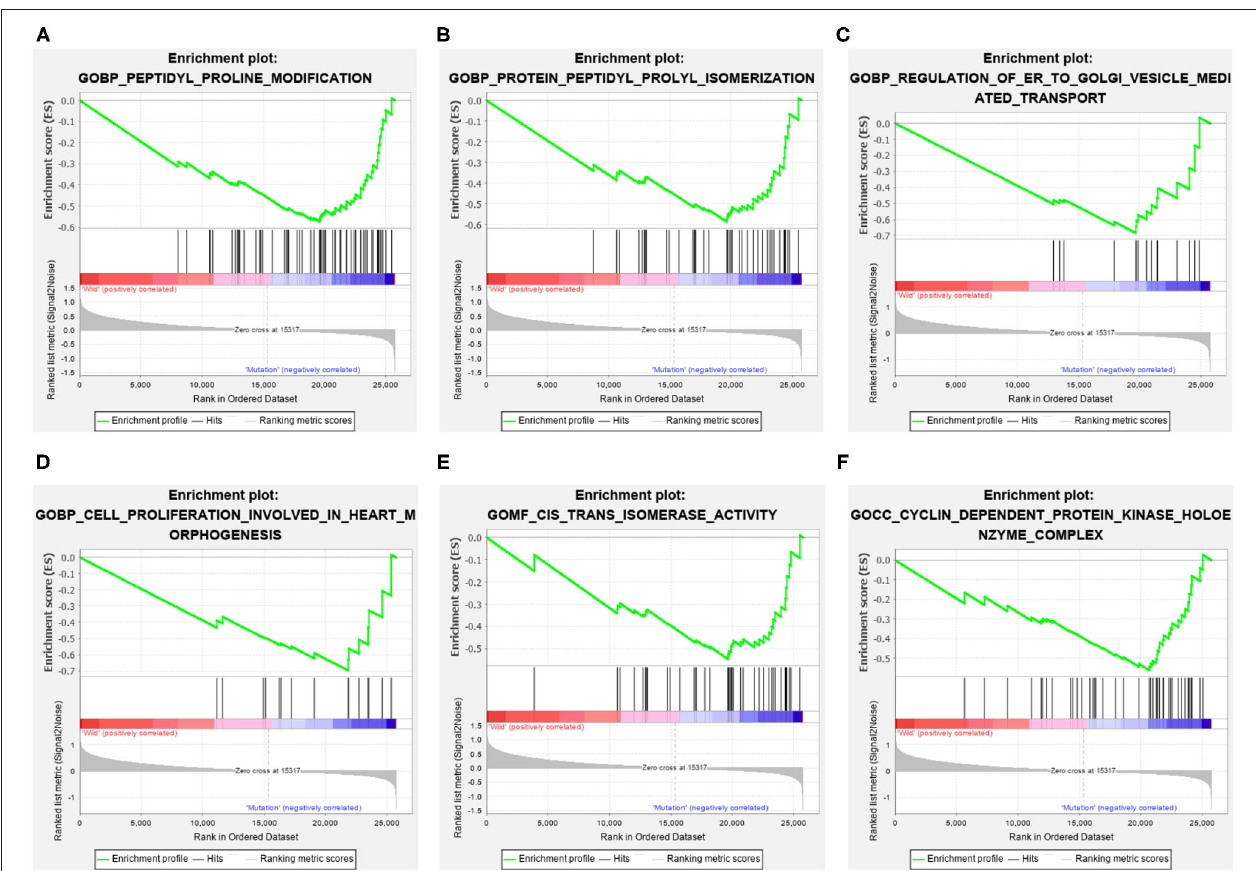
FIGURE 4 | The significantly enriched GO terms in mutated ELP6 GC samples based on GSEA. (A) Peptidyl proline modification, (B) protein peptidyl prolyl isomerization, (C) regulation of ER to golgi vesicle-mediated transport, (D) cell proliferation involved in heart morphogenesis, (E) cis trans isomerase activity, and (F) cyclin-dependent protein kinase holoenzyme complex. GO, Gene Ontology; GC, gastric cancer; GSEA, Gene Set Enrichment Analysis. of immune cells were significantly differentially infiltrated in wild-type and mutated ELP6 and PLIN5 GC samples.